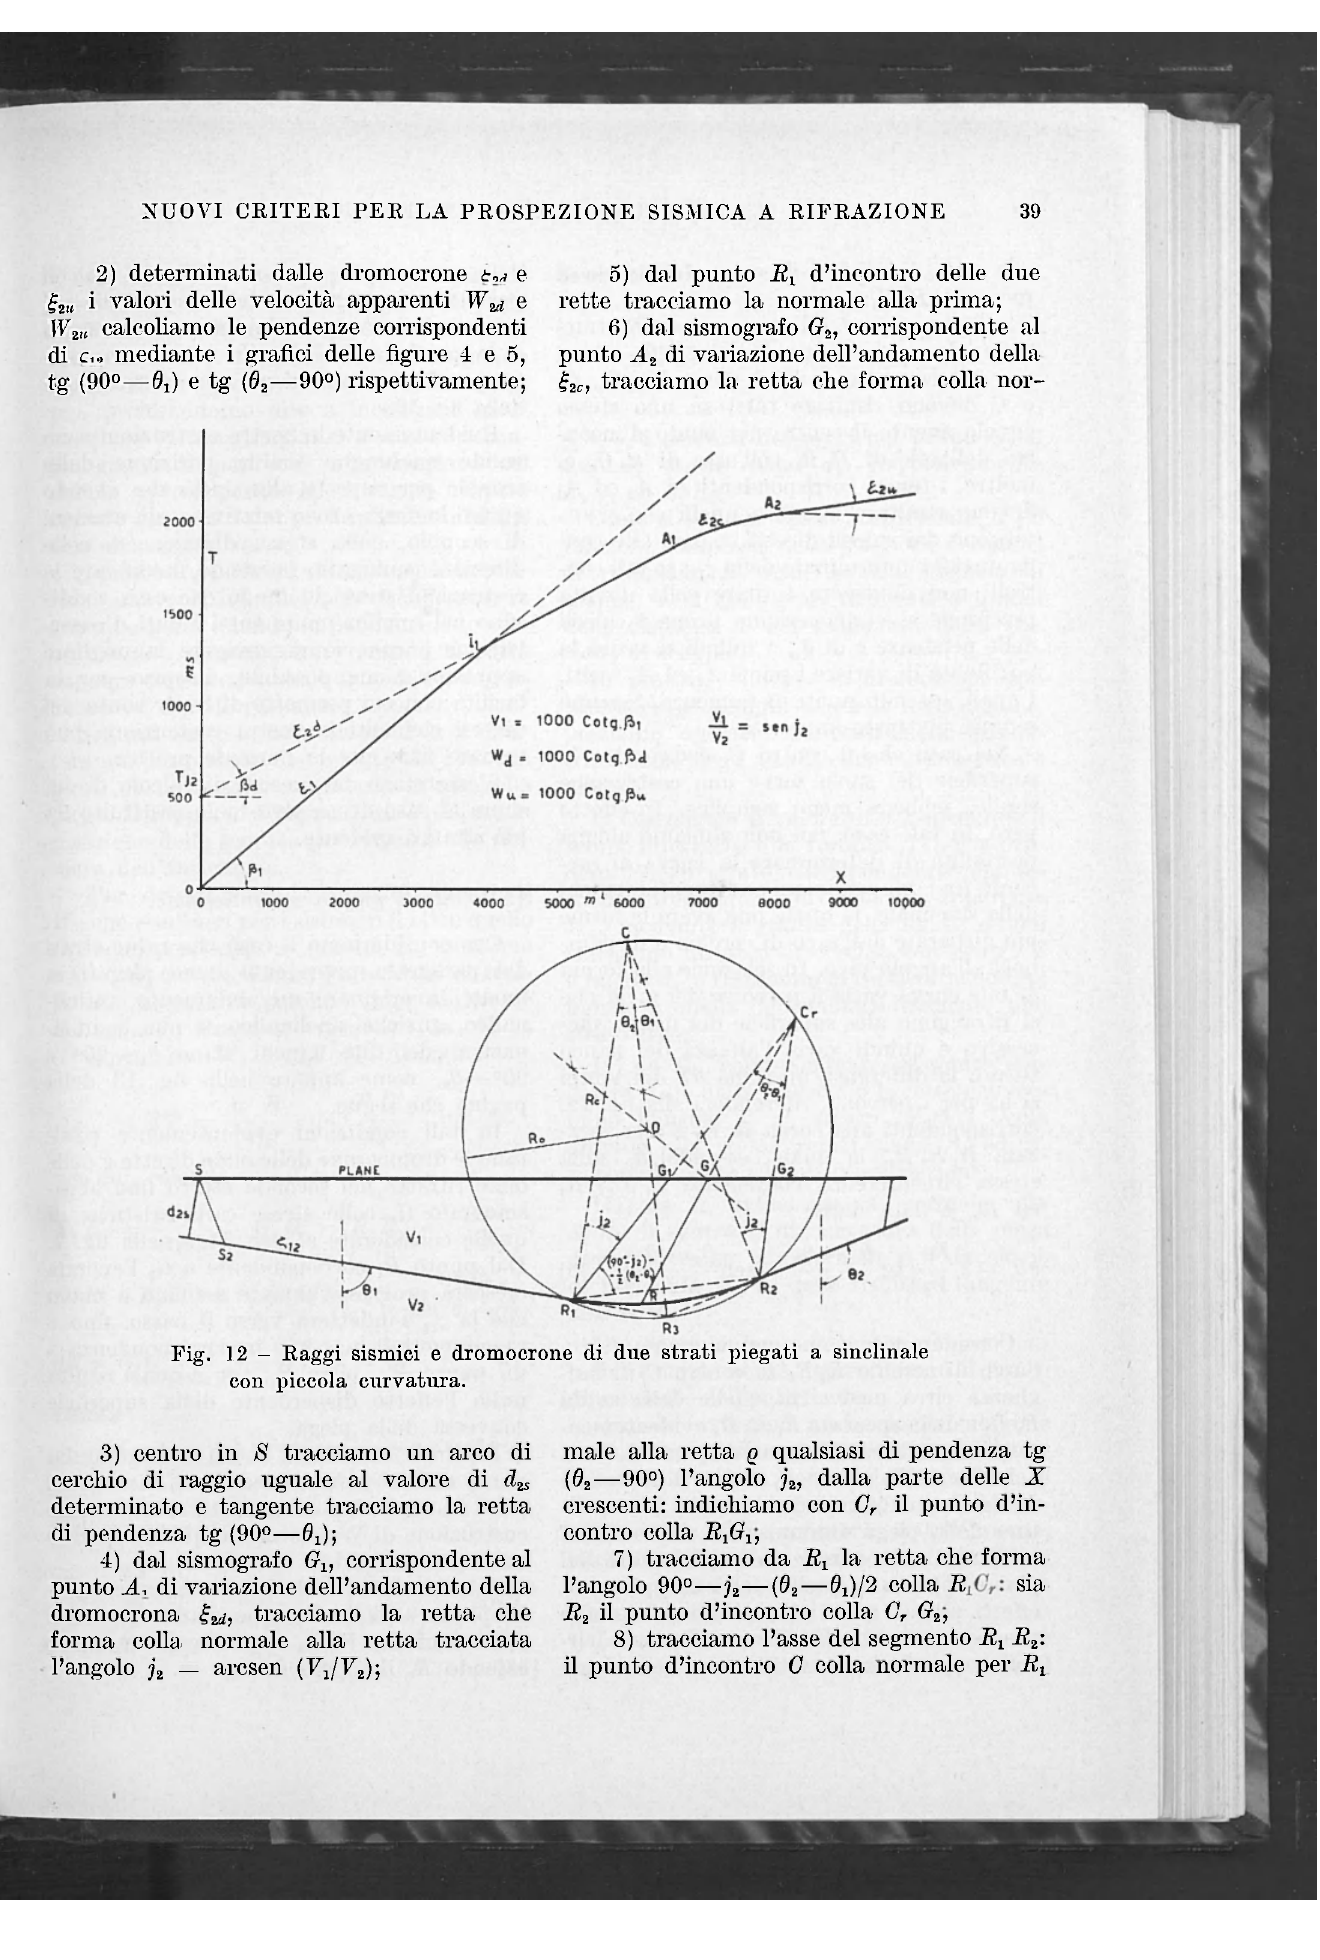
Fig. 12 - Raggi sismici e dromocrone di due strati piegati a sinclinale con piccola